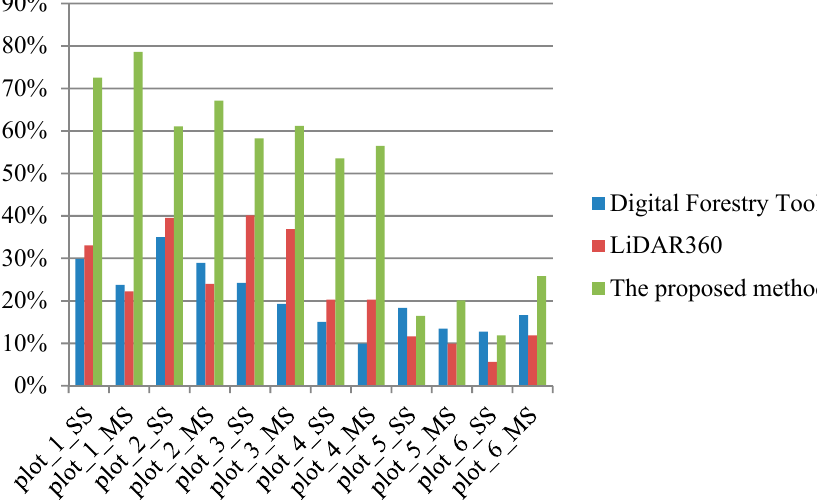
Figure 17. Comparison of mean accuracy of the three methods towards the six plots.